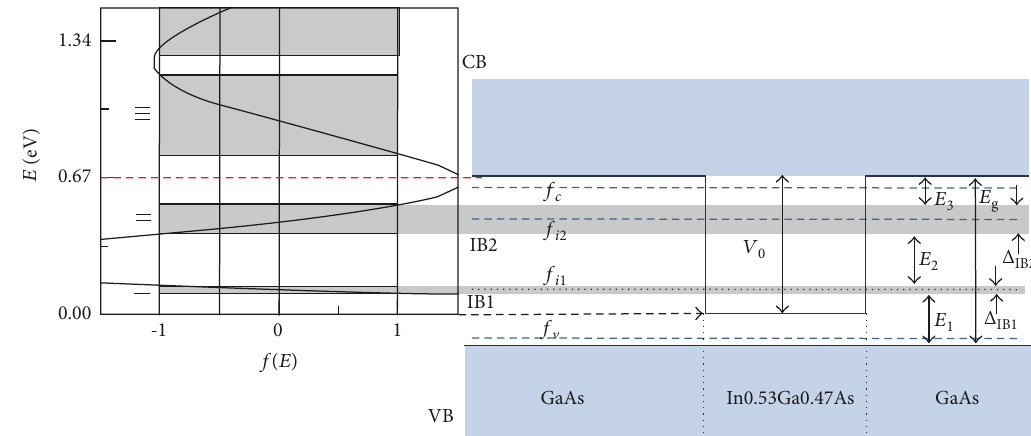
Figure 6: Energy band diagram and miniband dispersion of In intermediate